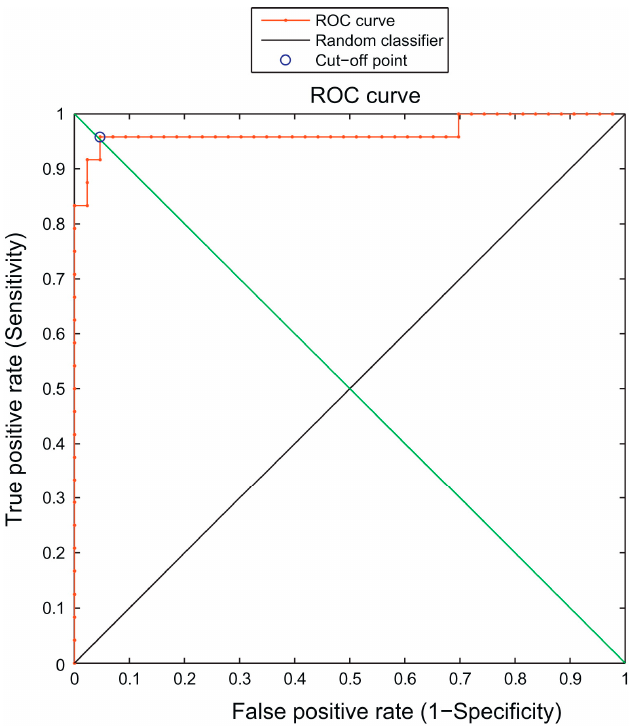
Figure 4. ROC curve analysis of the predicted probabilities of being normal mature neutrophils. The circle near the upper-left corner represents the cut-off point (51.79%) “Reproduced with permission from Ni et al., Computers in Biology and Medicine; published by Elsevier, 2013” [28] .